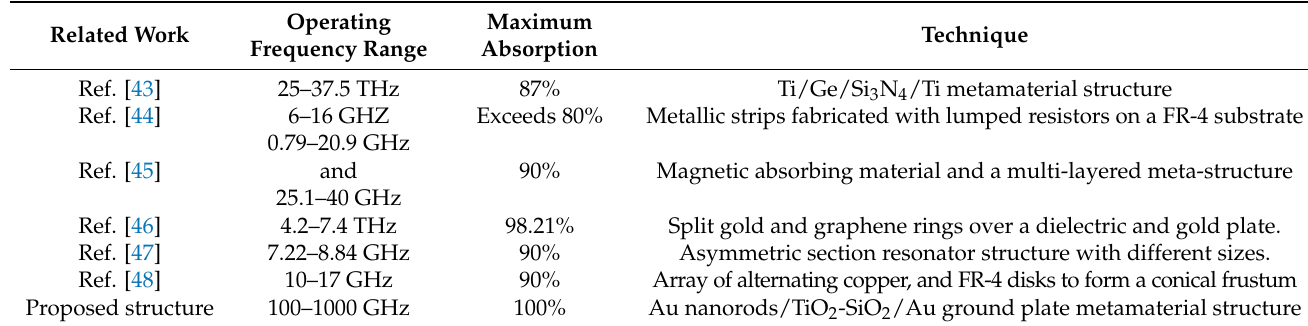
Table 5. Comparison of the MMA performance with recently reported MMAs.